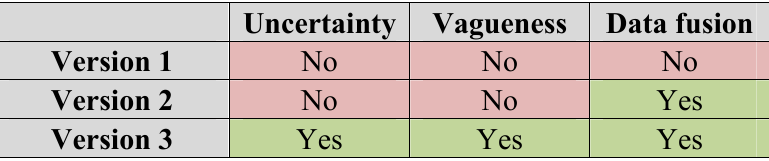
Table 3. Configuration of each version of the